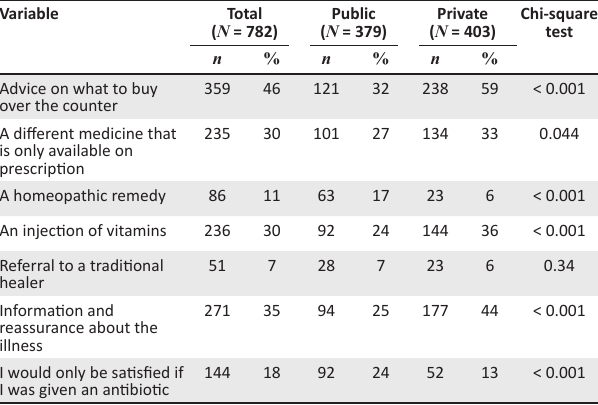
TABLE 4: Acceptable alternatives to